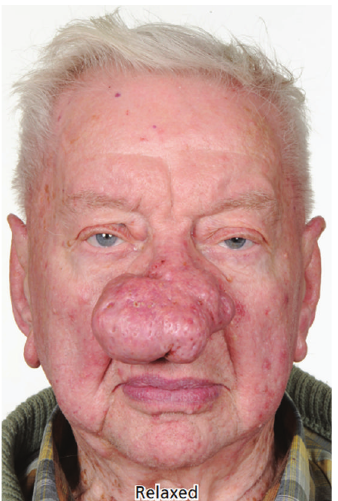
Figure 2: Case 3, preoperative frontal photo.